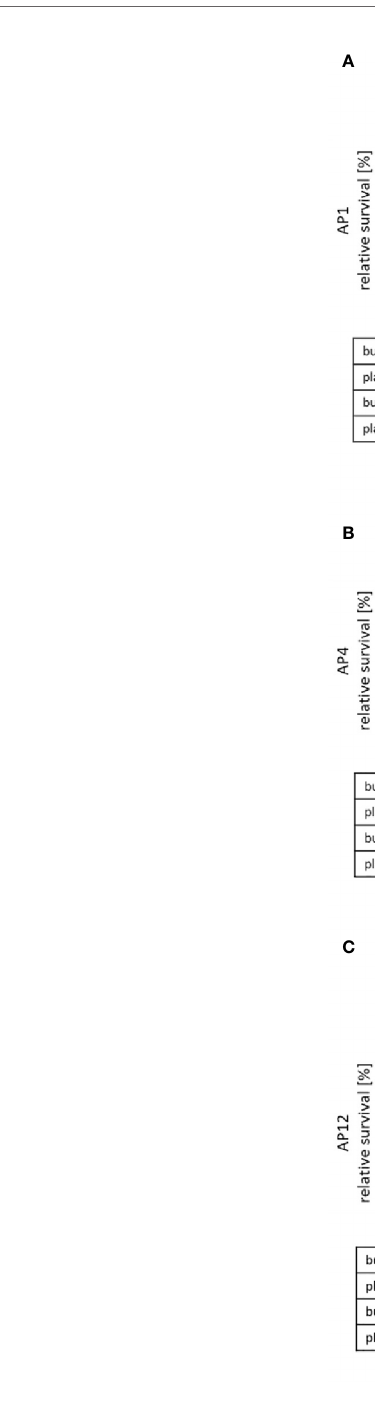
FIGURE 4 | Survival of the streptococcal strains AP1, AP4 and AP12 upon treatment with LL-37 and CTH. The bacterial strains AP1, AP4 and AP12 were grown to exponential phase before adding to 5% human plasma or assay buffer for 30min. After a washing step the bacteria were incubated for another 30min and 60min in the presence of LL-37 and CTH (A – C) . Incubation with buffer served as control. The graph represents the relative survival rate, calculated based on the platings for the 30min and 60min time points divided through the starting CFU before the plasma and buffer incubation. CFU counts were measured from 10 -4 dilutions on THY agar plates. The graphs display mean and standard error. Statistic tests performed on Prism (8.3.0) using a one-way ANOVA (Tukey ’ s multiple comparisons test) to compare buffer and plasma sample values at the same time point and to compare similar conditions over two timepoints. ***p ≤ 0.001, **p ≤ 0.01 and ns p=not signi fi cant. Signi fi cance was calculated based on technical quadruplicates per individual biological sample with performing the assay three times